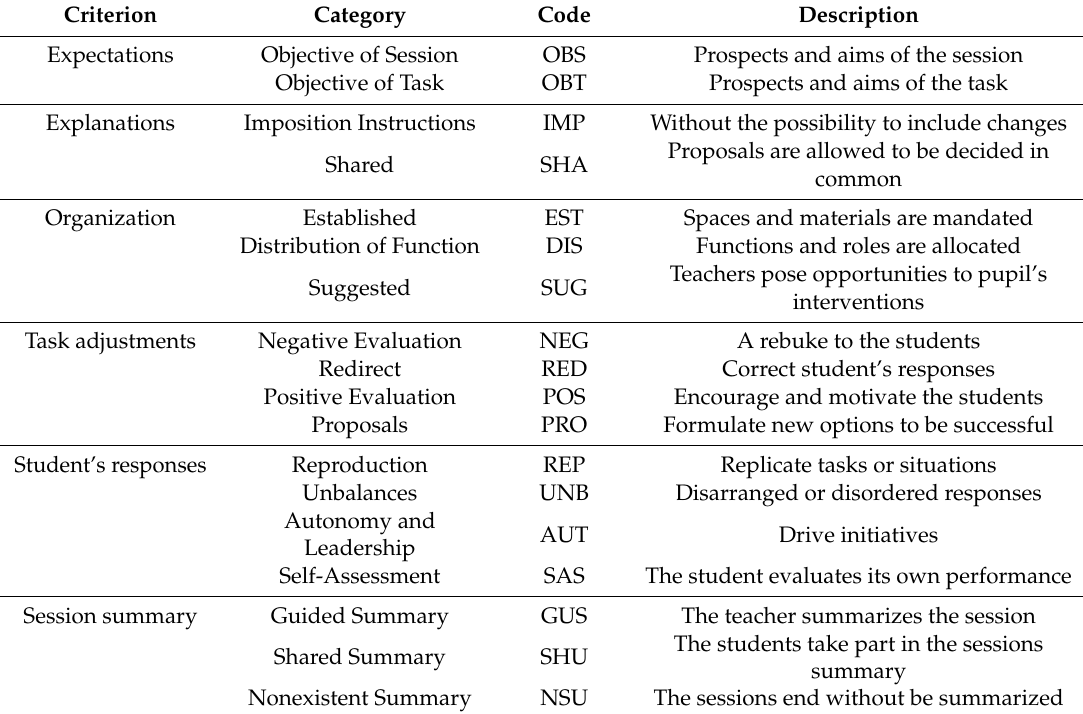
Table 1. Observational System of Teaching Oriented Responsibility (OSTOR) (Camerino et al. [23]). Criterion Category Code Expectations Objective of Session OBS Objective of Task OBT Prospects and aims of the task Explanations Imposition Instructions IMP Without the possibility to include changes Proposals are allowed to be decided in Shared SHA common Spaces and materials are mandated Functions and roles are